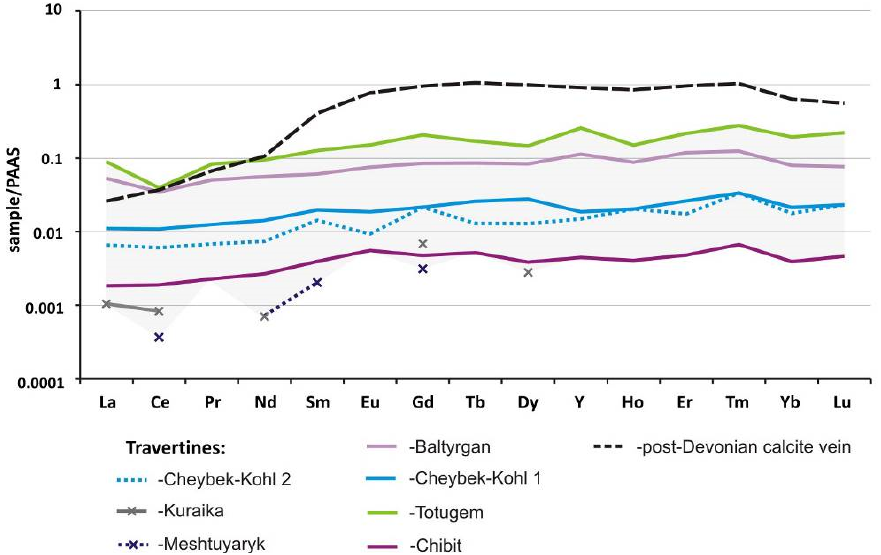
Figure 14. REE + Y patterns of CaCO 3 fractions extracted from travertines of the south-eastern Gorny Altai (cf. Table 3) compared to the post-Devonian calcite vein [41]. Normalized to PAAS [97].